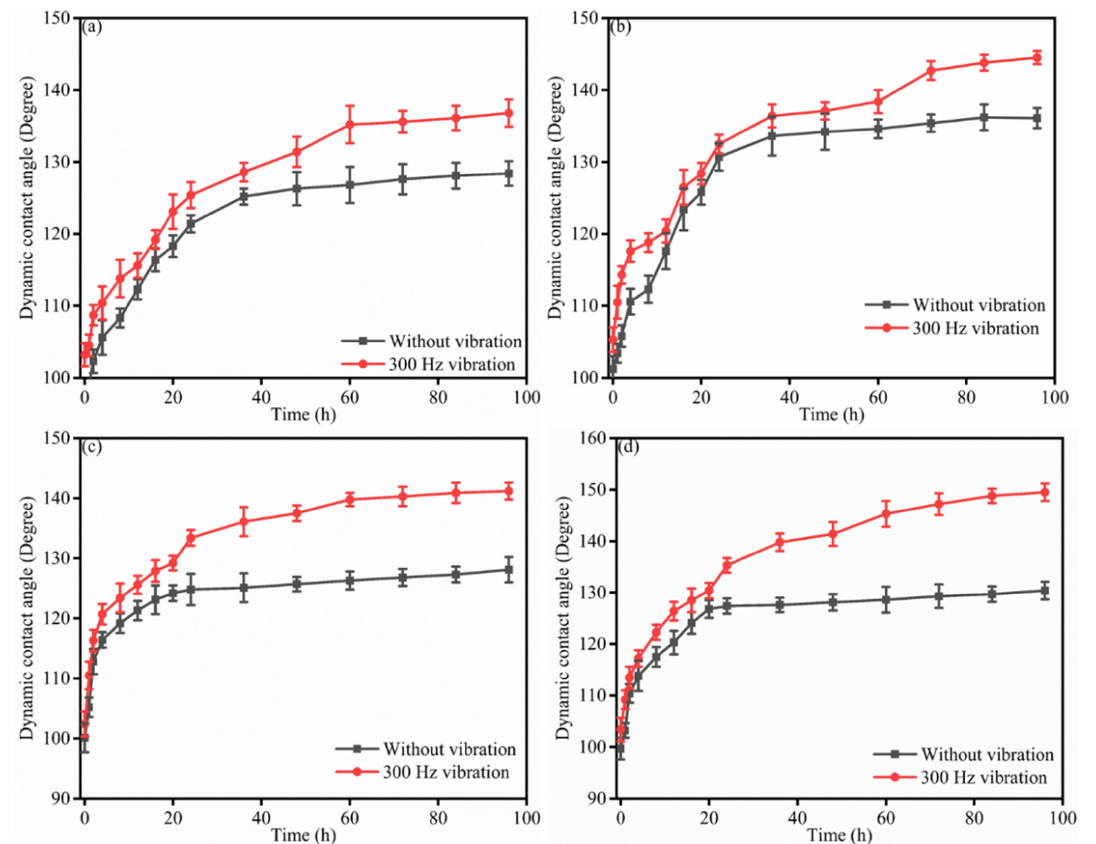
Figure 7. The water/solid/bitumen (0.1 wt%) dynamic contact angles of water drops onto the ( a ) iron casting; ( b ) steel; ( c ) PVC; ( d ) PE, with or without 300 Hz vibration.